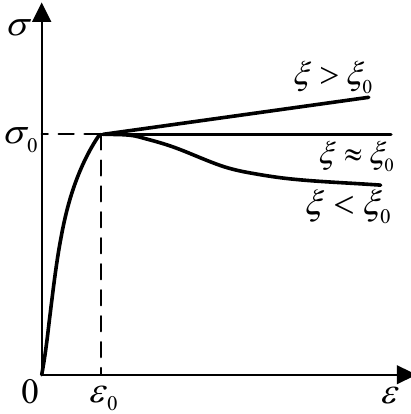
Figure 6. Stress–strain relationship of core concrete. The CDP damage plasticity model [23,24] is for the damage of external concrete in the process of stressing, and its tensile stress–strain expression is as follows: